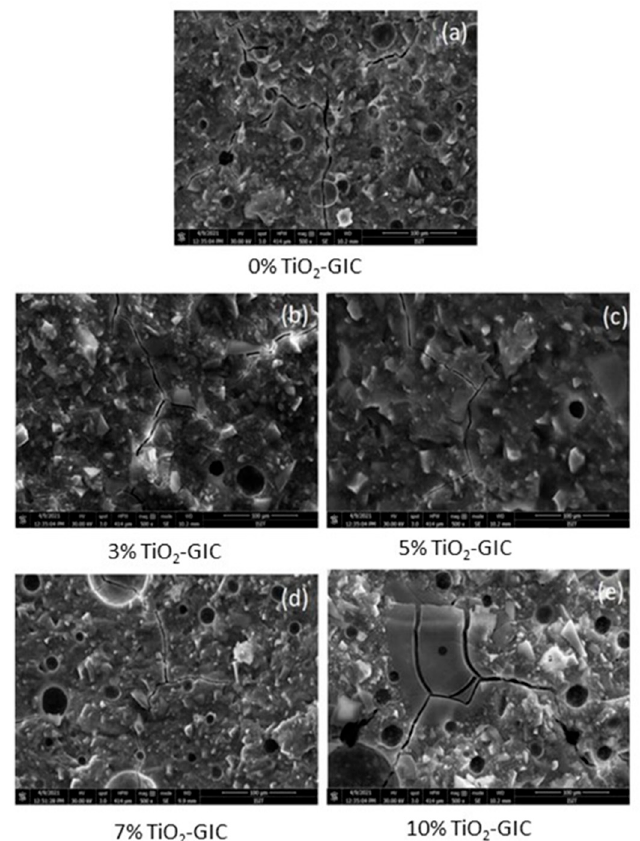
Figure 12. SEM images of TiO 2 -GIC samples at different concentrations after flexural strength testing (( a ) = 0%TiO 2 -GIC, ( b ) = 3% TiO 2 -GIC, ( c ) = 5% TiO 2 -GIC, ( d ) = 7% TiO 2 -GIC and ( e ) = 10% TiO 2 -GIC).